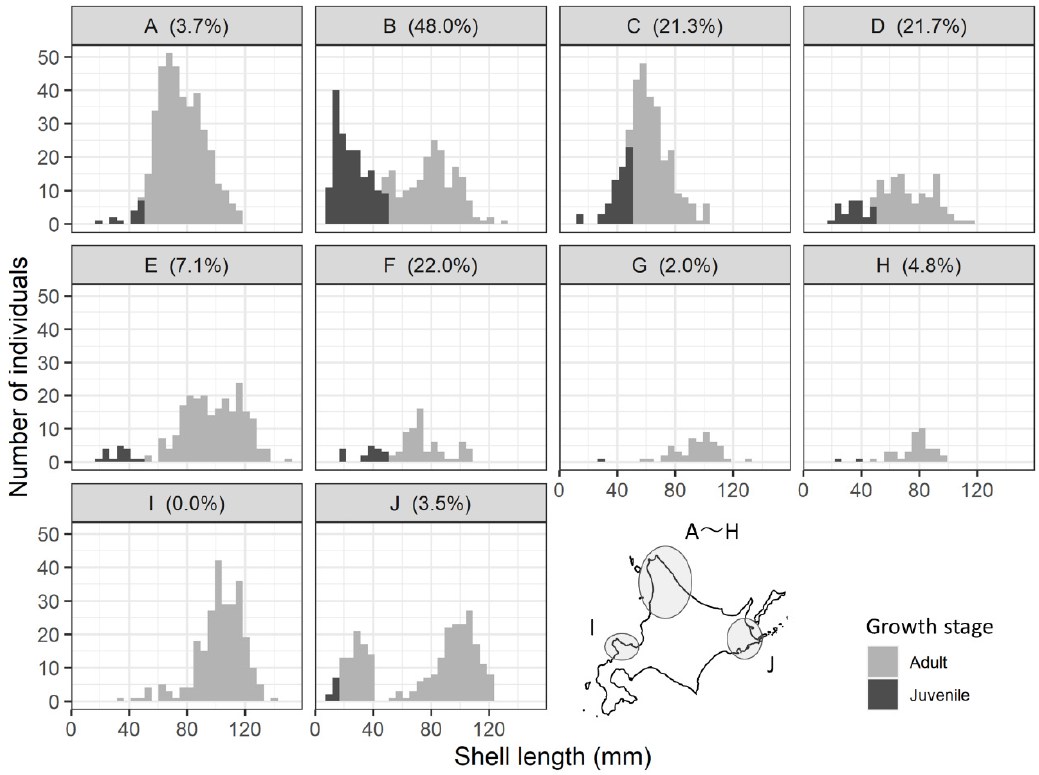
Figure 2. Shell length distribution in each study stream. Streams ( A – H ) are in northern Hokkaido, stream ( I ) is in central Hokkaido, and stream ( J ) is in eastern Hokkaido. The name and specific locations of the study streams are withheld to protect the habitat of M. laevis . The percentage next to the stream name is the percentage of juvenile mussels in each population.